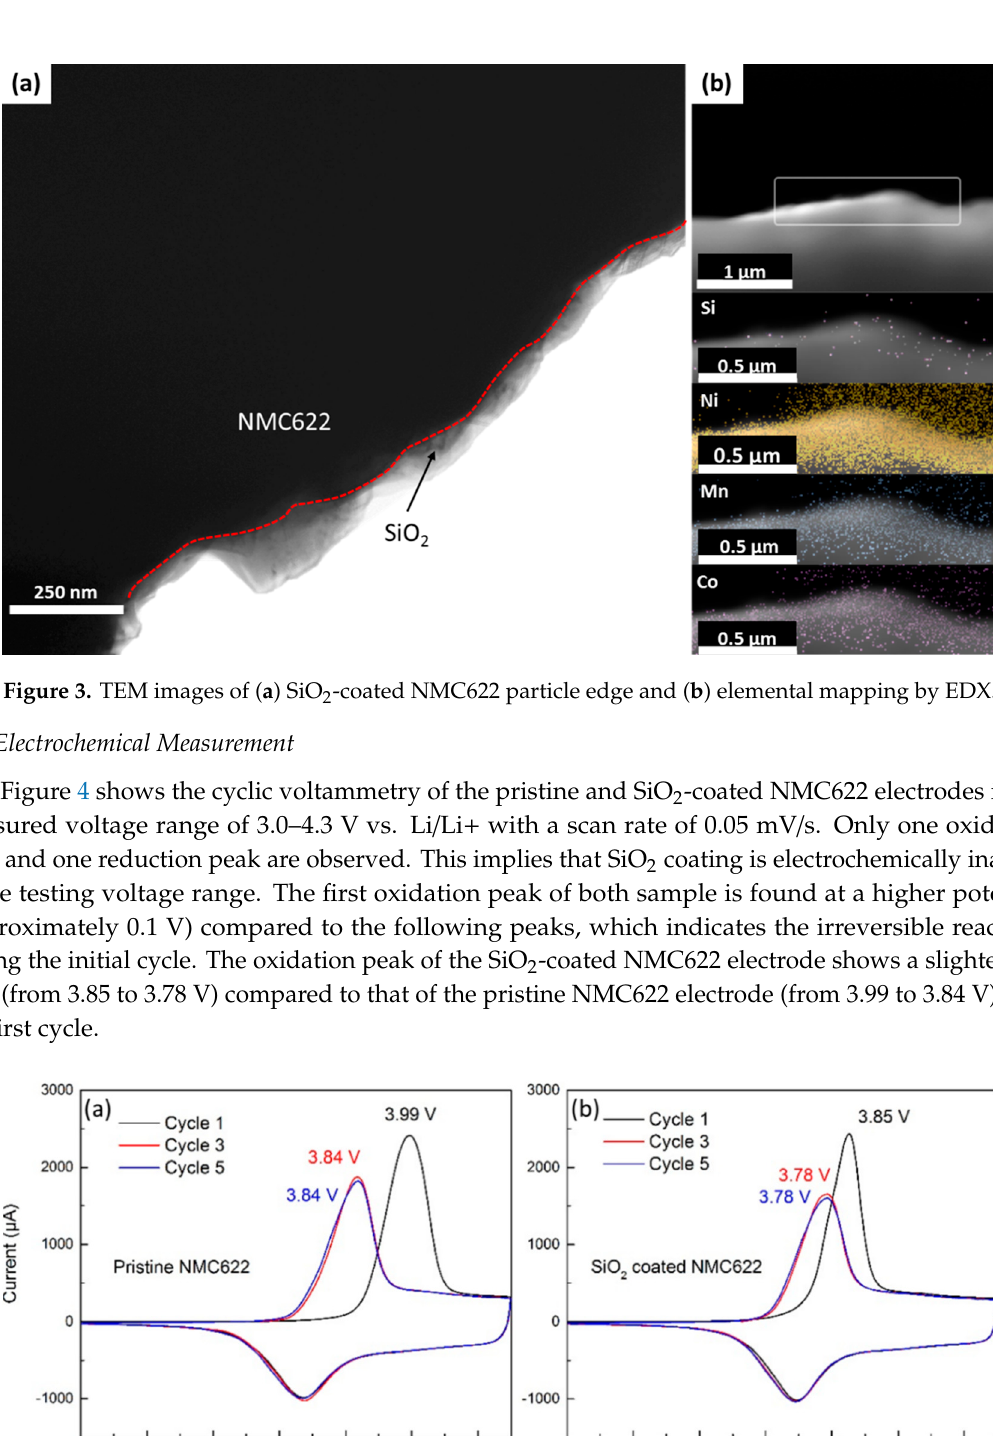
Figure 2. SEM images of ( a , b ) pristine and ( c , d ) SiO 2 -coated NMC622 particles in different magnification.